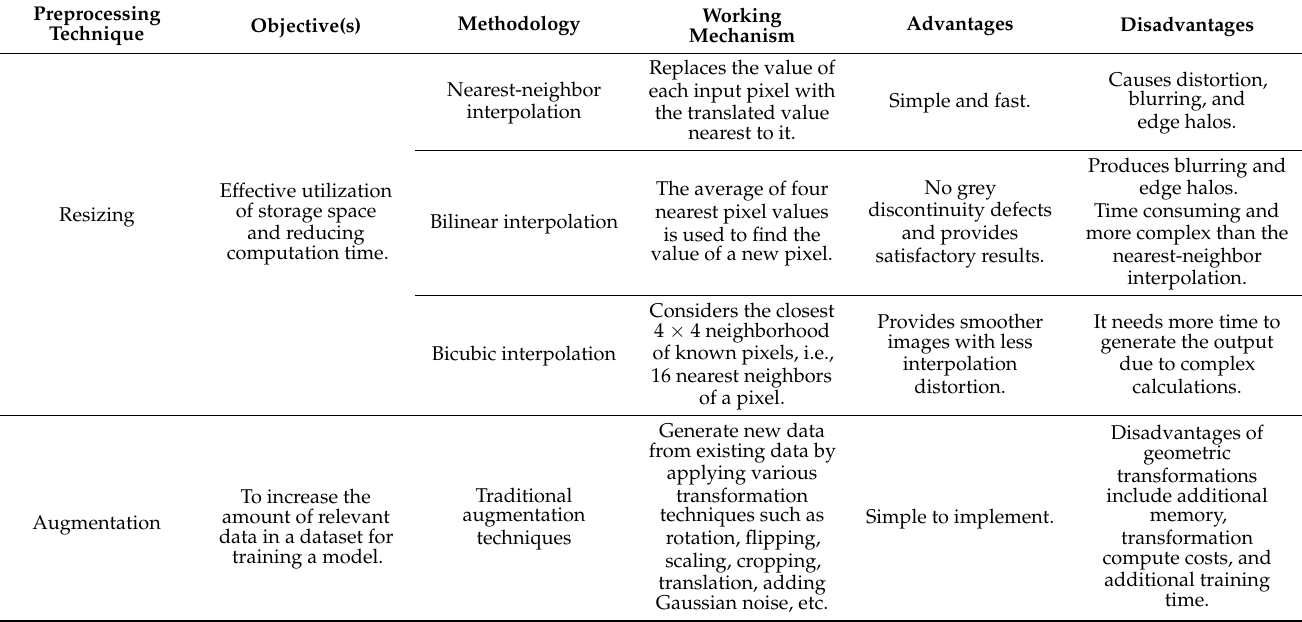
Table 2. Comparison of pre-processing